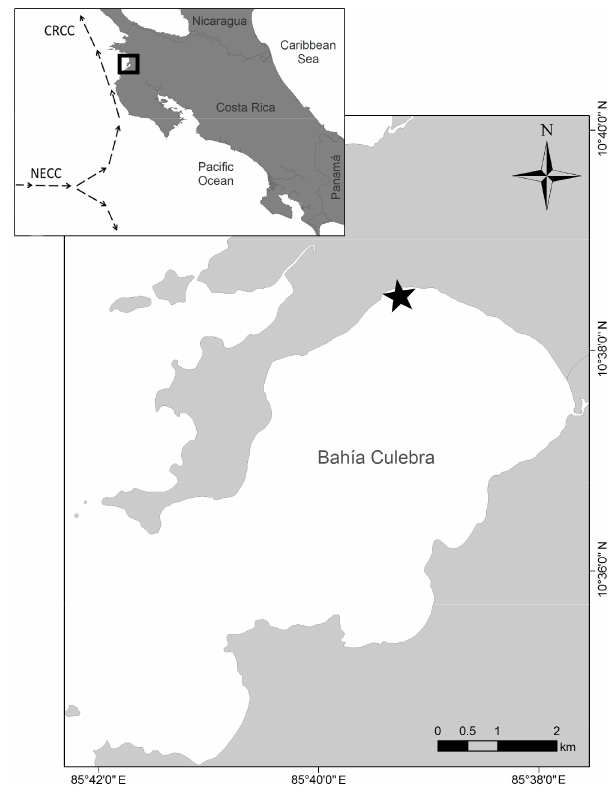
Figure 1. Location of Bahía Culebra (square) in the Gulf of Pa- pagayo, North Pacific coast of Costa Rica (insert). Measurements were made at Marina Papagayo (star). Main ocean currents influ- encing the Gulf of Papagayo (dashed arrows): NECC indicates the North Equatorial Countercurrent; CRCC indicates the Costa Rica Coastal Current.